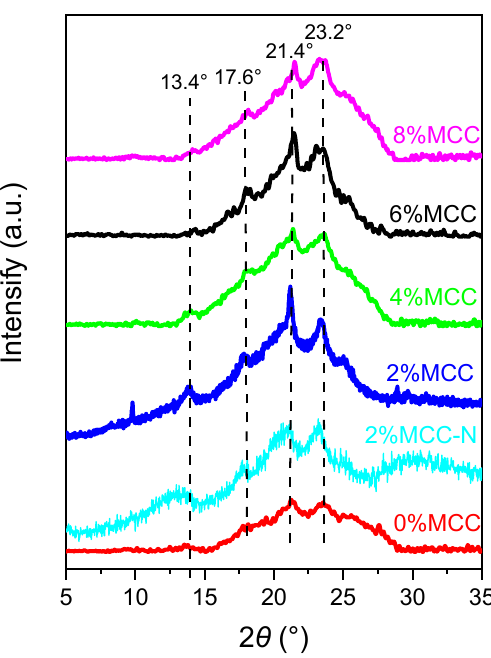
Figure 2. XRD patterns of the samples.